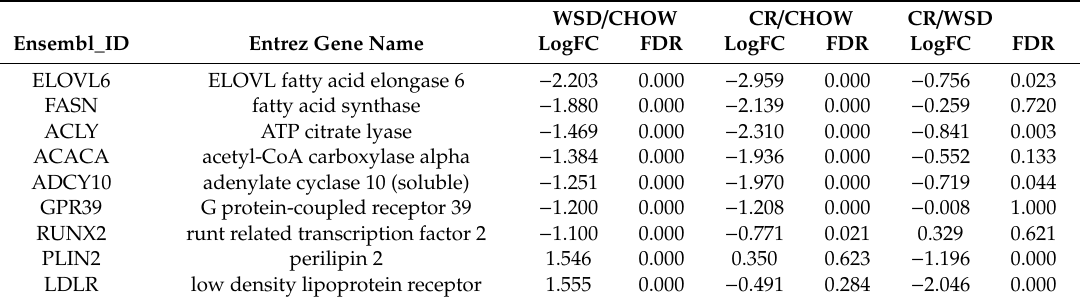
Table 2. Top metabolic genes di ff erentially regulated by western-style diet (WSD) and caloric restriction